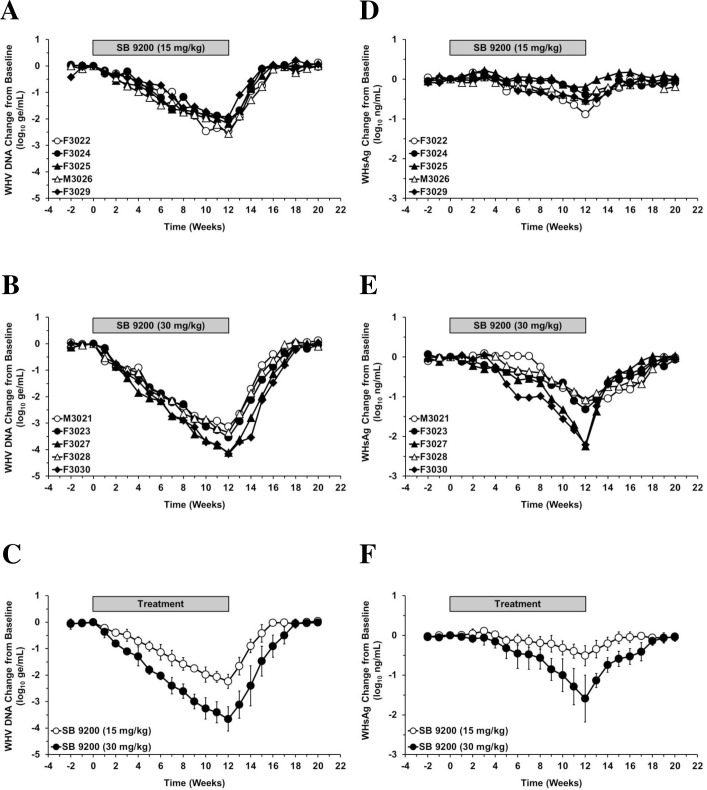
SB 9200 treatment induces dose-dependent, transient suppression of serum viremia and antigenemia.Changes in WHV DNA (left panels) and WHsAg levels (right panels) relative to T0 (pretreatment baseline) during daily, oral treatment with SB 9200 for 12 weeks in individual woodchucks administered a low (A, D) or high dose (B, E) and mean of each group (C, F). At T0, mean WHV DNA levels were 4.78x1010 and 5.27x1010 genomic equivalents/mL serum and mean WHsAg levels were 3.30x105 and 4.32x105 ng/mL serum in the low or high dose groups, respectively. Error bars represent the standard error of the mean.